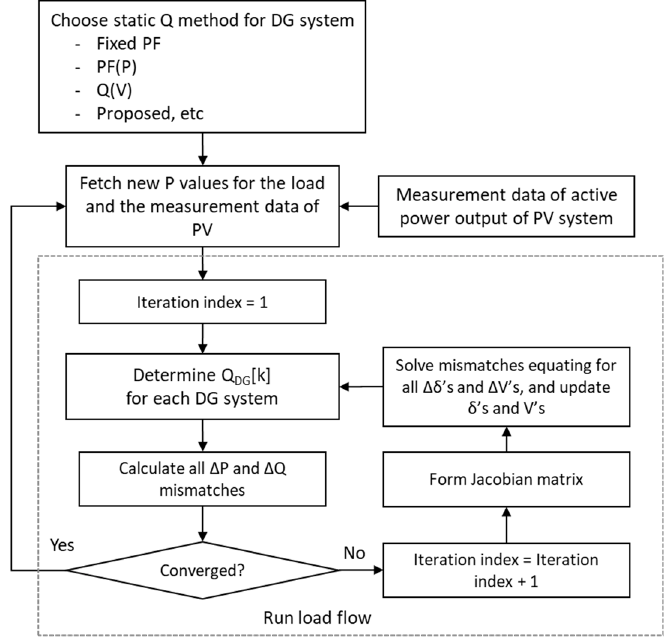
Figure 8. Flowchart of load flow including reactive power control of renewable energy system. Figure 9. Flowchart of load flow including reactive power control of renewable energy